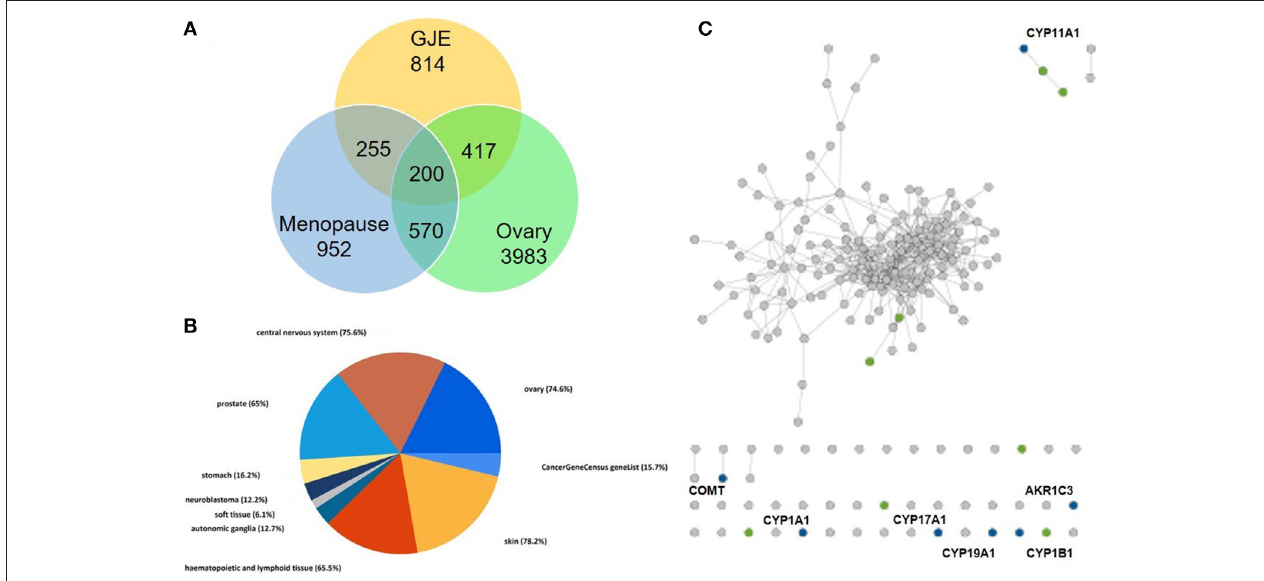
FIGURE 3 | Steroidogenesis under influence of GJE was predicted by network pharmacology. (A) The Venn diagram of targets from the ovaries, menopause and GJE regulated. (B) The pie chart of tissue specificity of bioactive compounds in GJE. (C) Chemical-protein interactions related to steroid hormone biosynthesis pathways. “gray dots” represent genes in the target set, “green dots” represent genes associated with steroid biosynthesis pathway, “blue dots” represent the overlap between the related pathway and the input protein